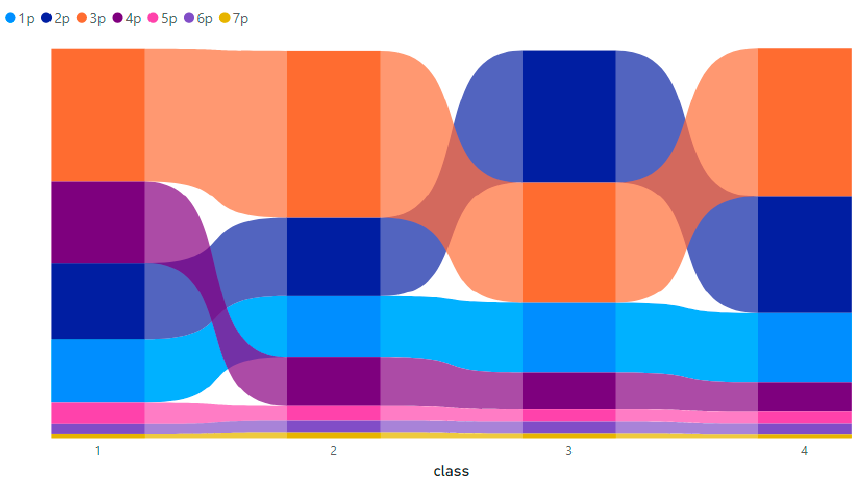
Figure 11. Housing size (1p: one room, 7p: seven rooms).